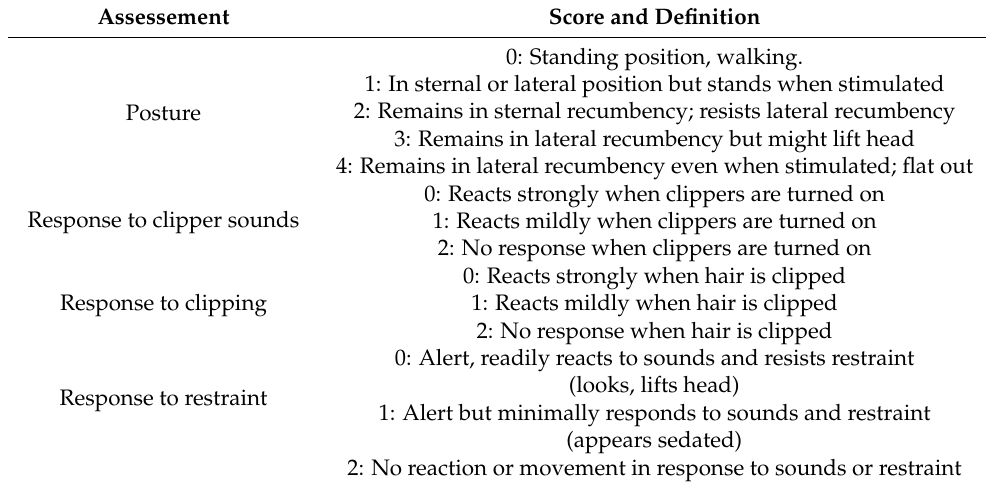
Table 1. Criteria for evaluating the level of sedation in cats: assessment score and definition (Santos et al., 2010). Evaluation criteria are: posture, response to the sound of clippers, response to clipping, and response to restraint, where 0 is no sedation and 8 is no response to acoustic and tactile stimuli. Lower score is bad sedation and higher scores indicate greater